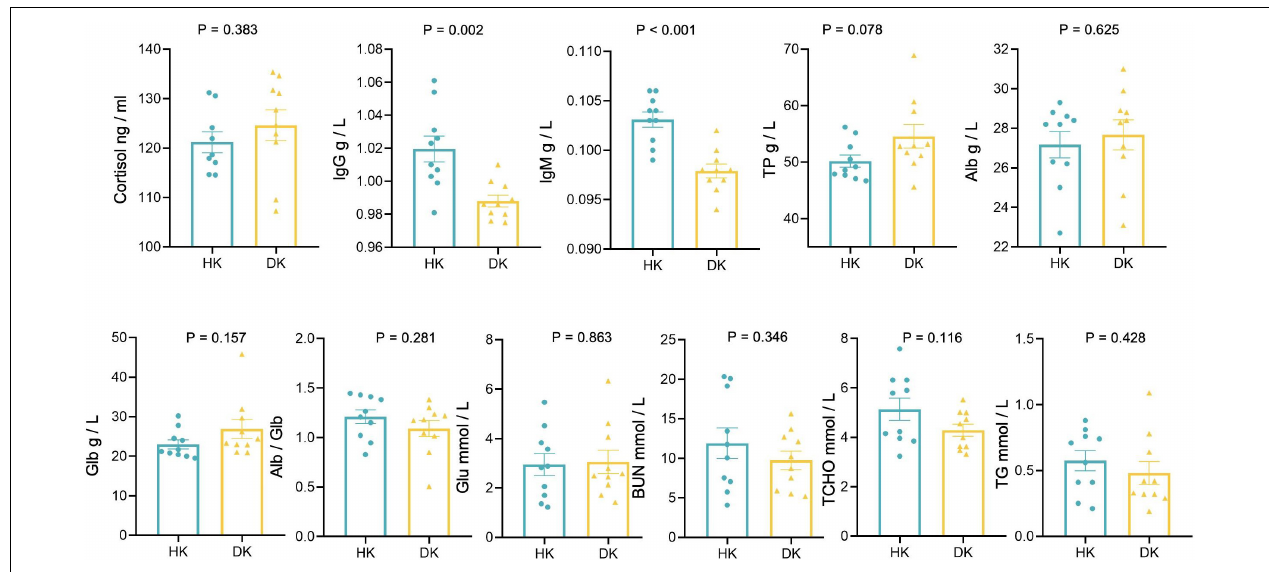
FIGURE 7 | Serum biochemical and cortisol measurements of diarrheic and healthy goat kids; data represent mean values ± standard error of mean (SEM), n = 10.